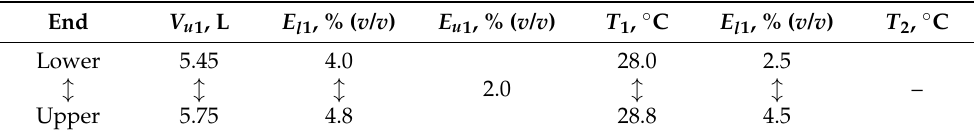
Table 5. Upper and lower end of the ranges over which the operational variables minimized ( r A ) global est